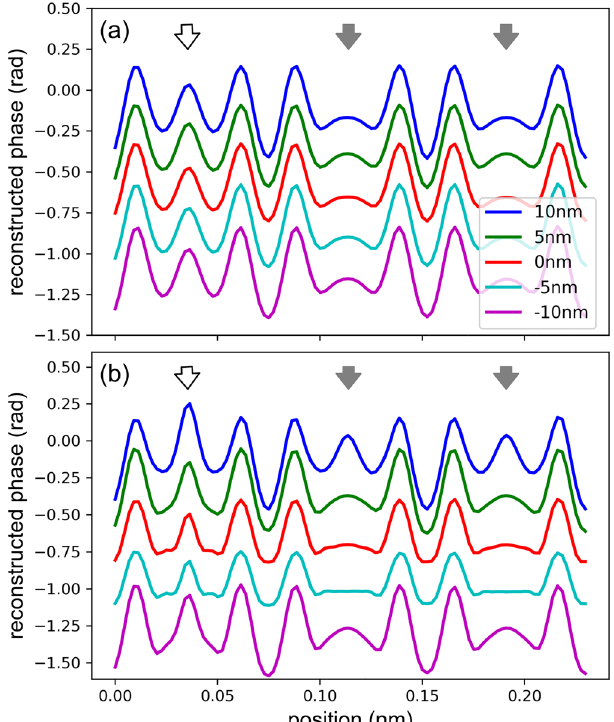
Figure 3. Profiles taken along the line at the center of black rectangle in Fig. 1a for the acquisition defocuses of 10, 5, 0, − 5, and − 10 nm and the convergence semi-angles of a 13.5 mrad and ( b ) 20.8 mrad. The white and gray arrows mark the centers of six-membered ring columns with and without Cu, respectively. The reconstruction defocus is chosen so that it compensates for the acquisition defocus. The profiles are vertically shifted for display